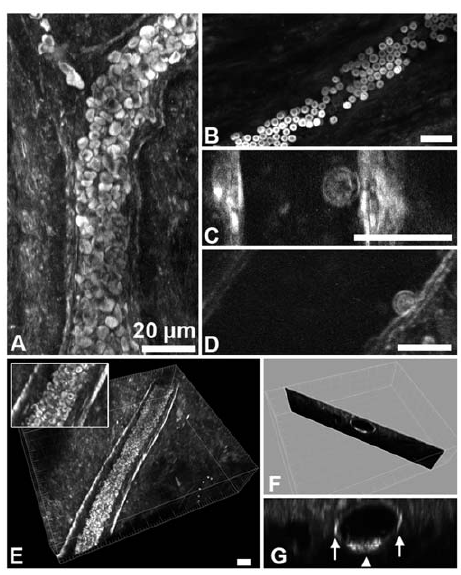
Figure 2. THG of blood vessels and blood cells in explanted, unfixed cremaster muscles recorded in forward direction. A) Projection of optical sections. Without flow, red blood cells (RBCs) sink to the bottom of the vessel, forming a tightly packed mass. B) Visualization of typical RBC shape. C,D) Leukocytes adhering to the inner vessel wall. E–G) Blood vessel with strong THG signal from the vessel wall. Vessel diameter is between 40 and 45 m m. E shows a 3D rendering with a 2x magnification in the inset. A section perpendicular to the vessel axis is shown in F and the same section is magnified in G. The arrows point to the prominent THG signal from wall sections parallel to the optical axis, the arrowhead points to the RBCs at the vessel bottom. All scale bars are 20 m m.